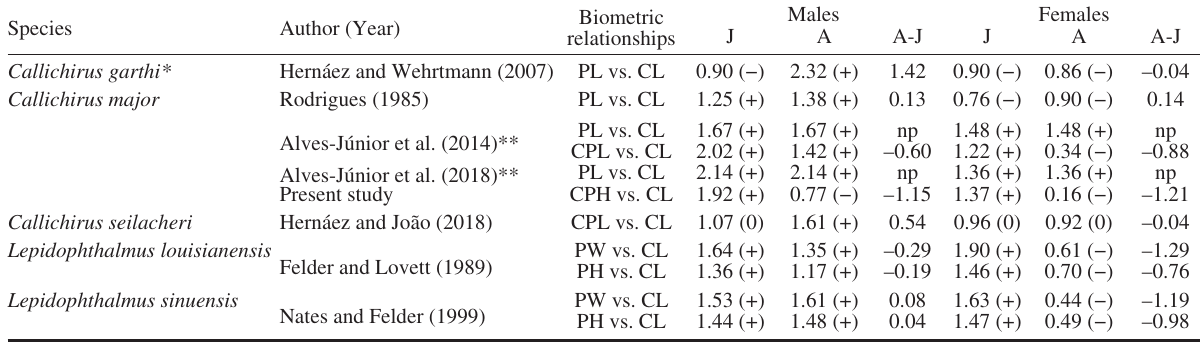
Table 3. – Relative growth patterns (0, isometry; +, positive allometry; −, negative allometry) in Callianassidae, by sex and development phases (J, juveniles; A, adults), considering carapace length (CL) as an independent variable in function of the dependent variables (CPH, carpus height; CPL, carpus length; PH, propodus height; PL, propodus length; PW, propodus width), measured in the major cheliped. A-J, difference level of allometry between adults (A) and juveniles (J); np, not possible. * Currently accepted as Callichirus garthi ; ** Positive allometric growth informed for each sex, but not for each development phase.